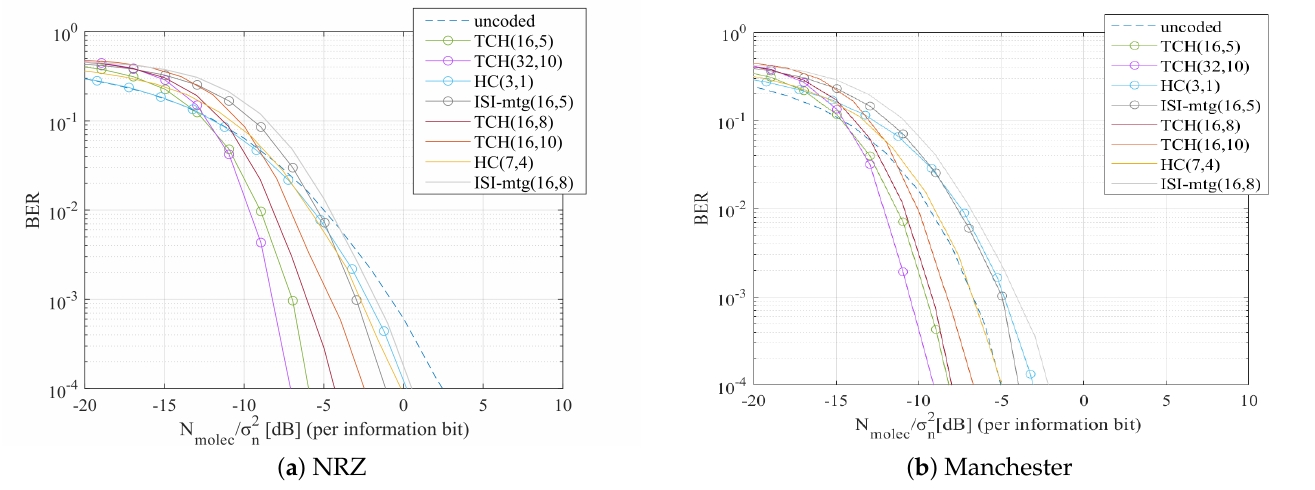
Figure 6. BER comparison for all the considered channel codes, using BCSK modulation and with τ = 2.